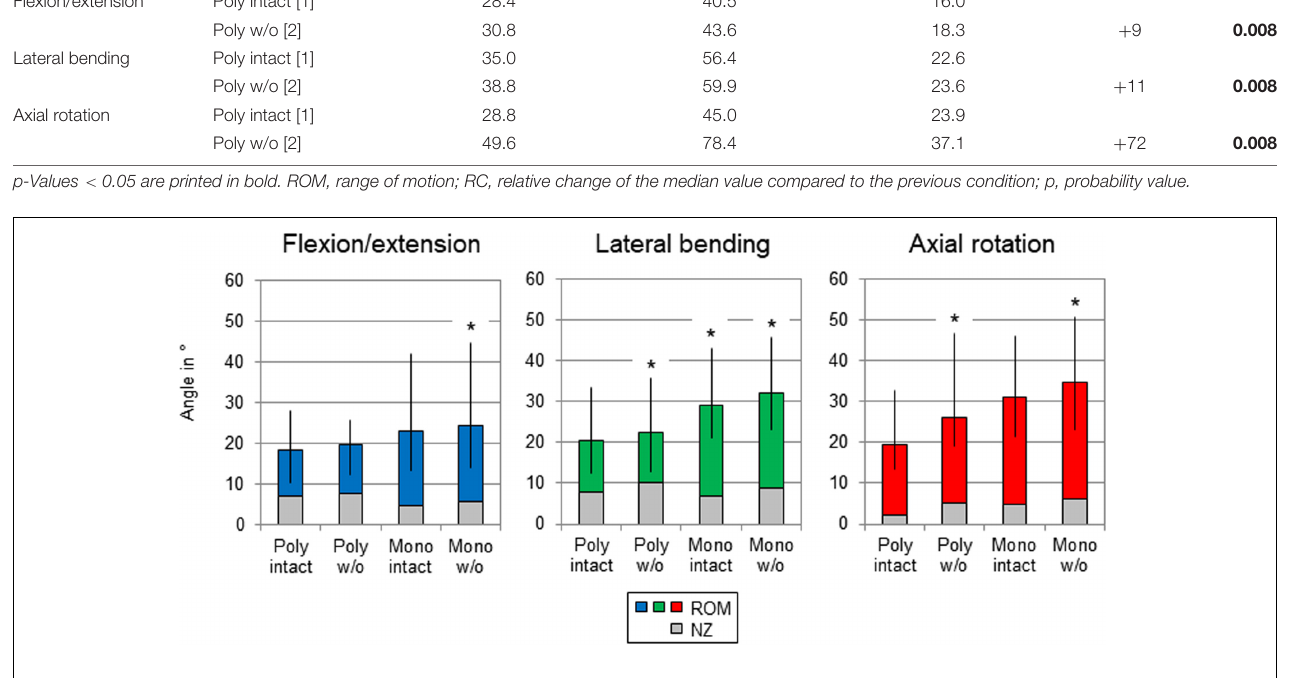
FIGURE 4 | Graphical illustration of the results for T1-T12 ROM and NZ as sum of the six tested segmental levels (T1-T2 + T3-T4 + ... ) at pure moments of ± 5 Nm ( n = 8) depending on primary motion plane and testing step. Significant differences compared to the previous condition ( p < 0.05) are marked with an